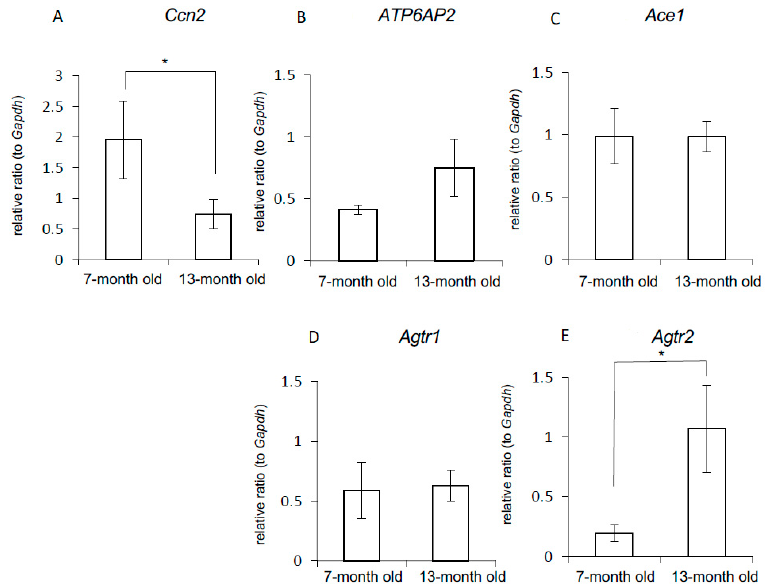
Figure 6. Change in the gene expression of CCN2 and RAS components accompanied by aging. Chondrocytes were isolated from the xiphoid process of mice at 7 and 13 months of age. These cells were grown until they reached confluence. Then, total RNA was isolated, and quantitative RT-PCR analysis was performed by using the indicated primers. The amounts of these mRNAs were normalized to that of Gapdh mRNA. The graphs show the expression levels of ( A ) Ccn2 , ( B ) Atp6ap2 , ( C ) Ace1, ( D ) Agtr1, and ( E ) Agtr2. The asterisk indicates a significant difference (* p < 0.05). The data were analyzed by using the unpaired Student’s t -test.